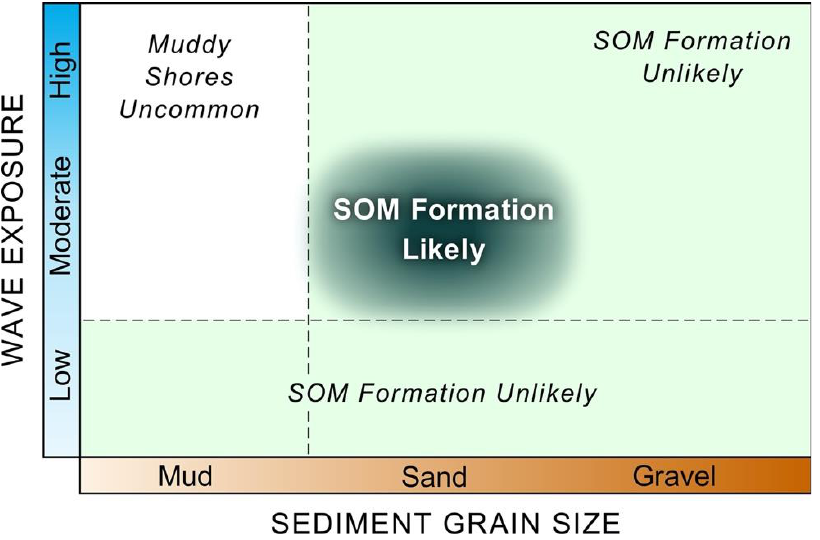
Figure 3. Wave exposure and sediment grain size conditions when SOM formation is likely or not. Based on initial sketch from John Harper, Coastal and Ocean Resources.